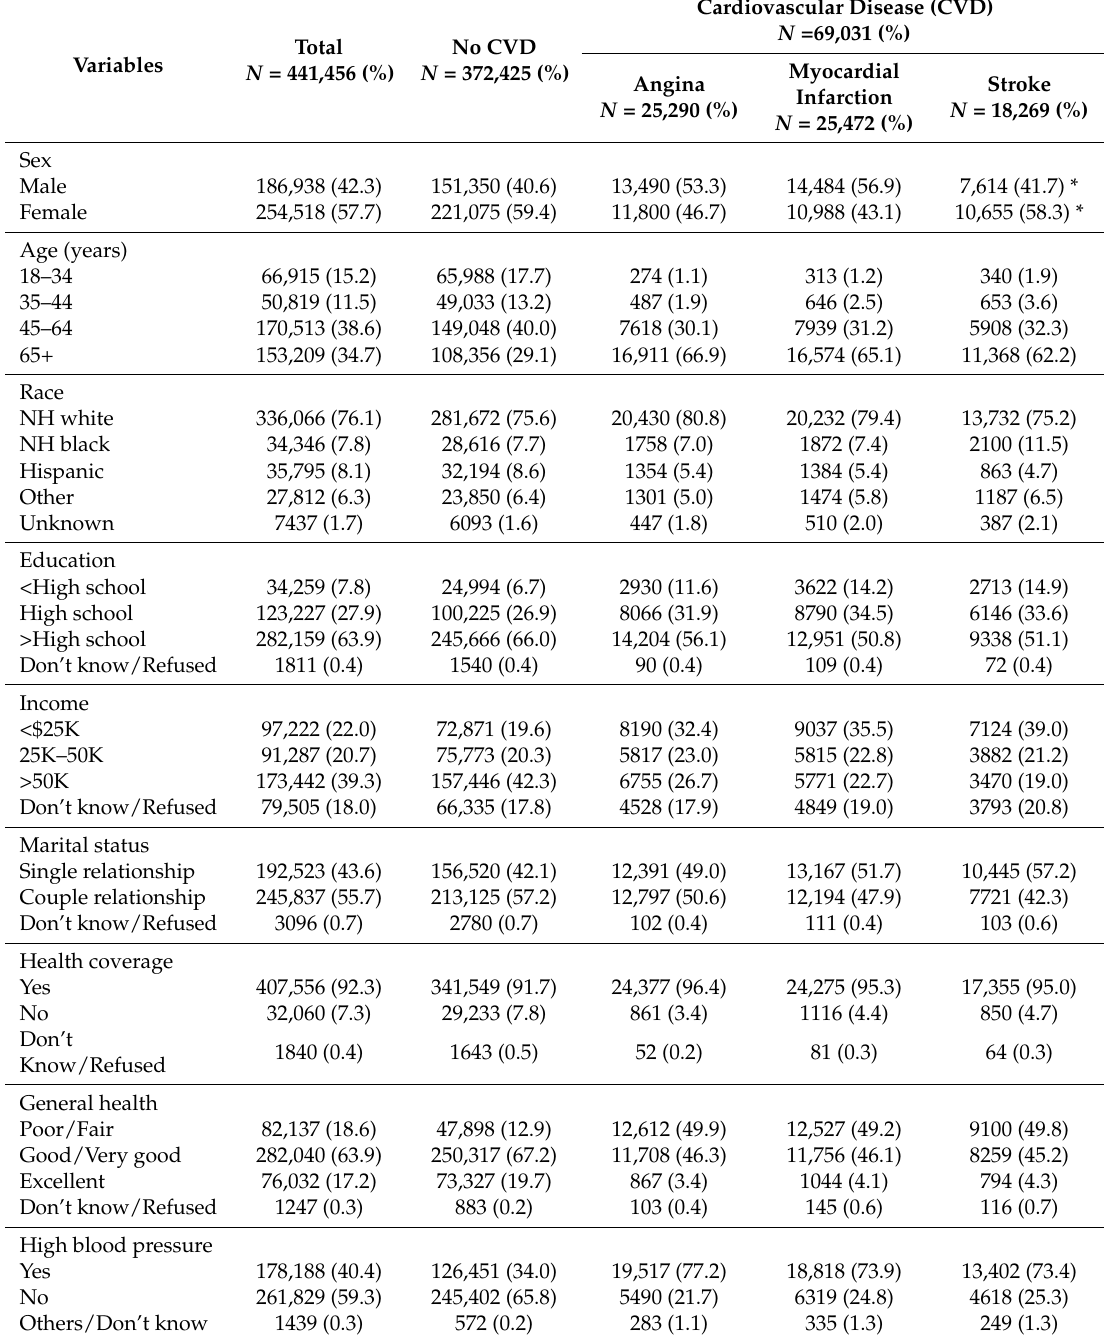
Table 1. Sociodemographic and clinical characteristics of the study population by CVD Status: BRFSS 2015